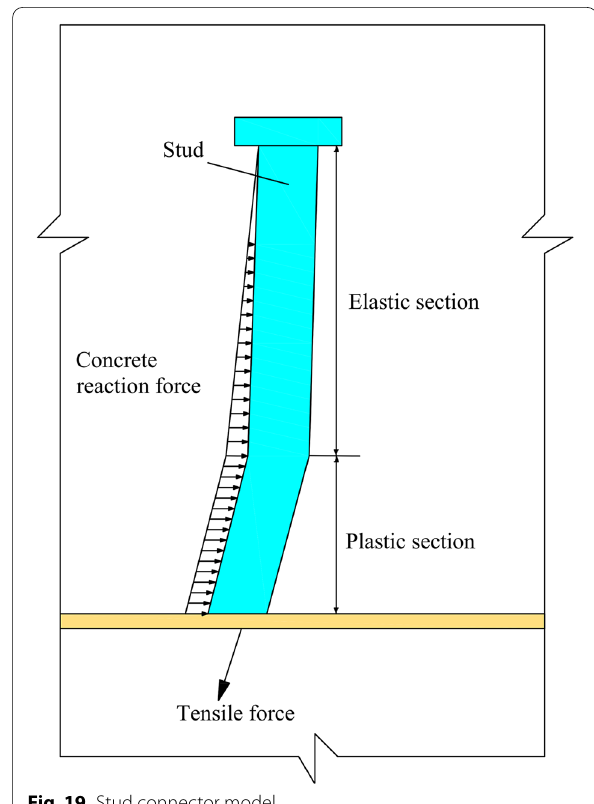
Fig. 19 Stud connector model.